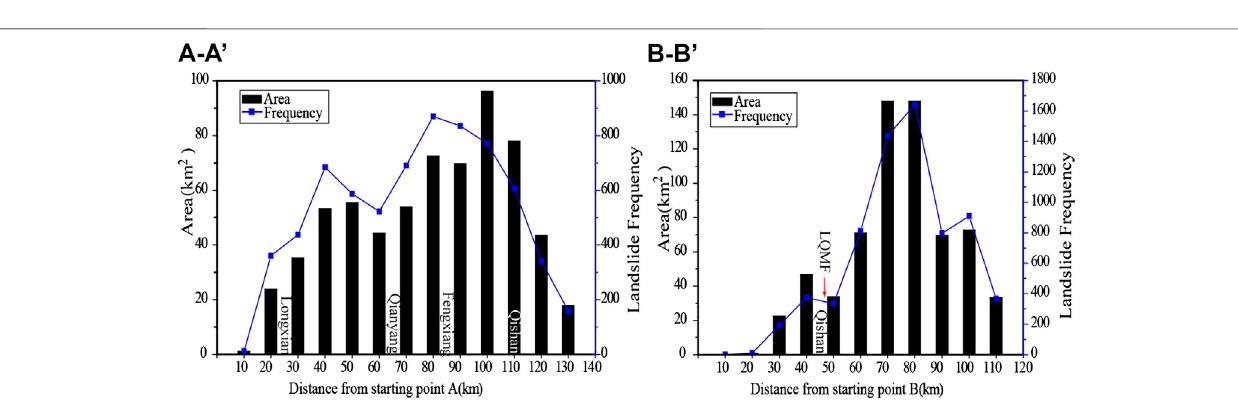
Frontiers in Earth Science |